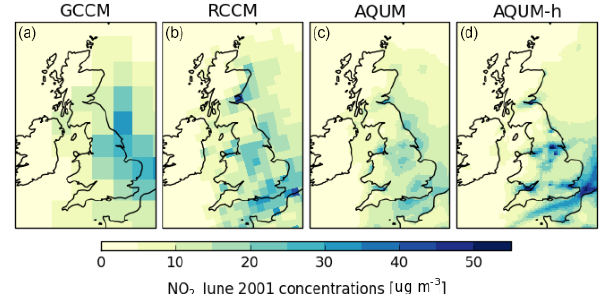
Figure 3. Monthly mean NO 2 concentrations over the UK for June for the four different model runs. From left to right: GCCM, RCCM, AQUM,